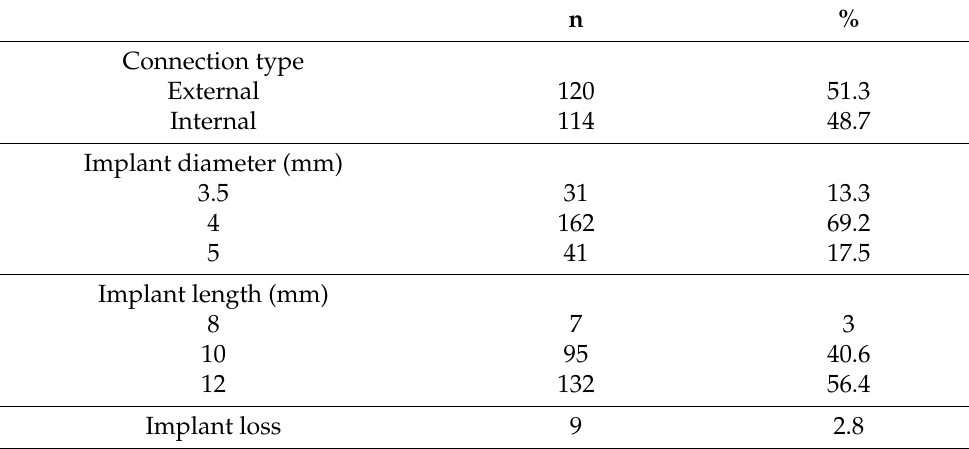
Table 3. Description of implant